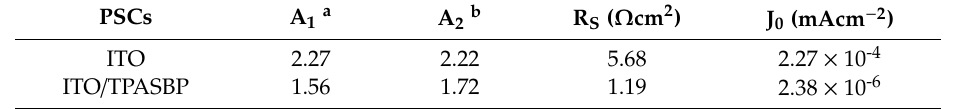
Table 2. Fitted electrical parameters of PSCs with perovskite film fabricated on ITO and ITO / TPASBP, respectively. PSCs A 1 a A 2